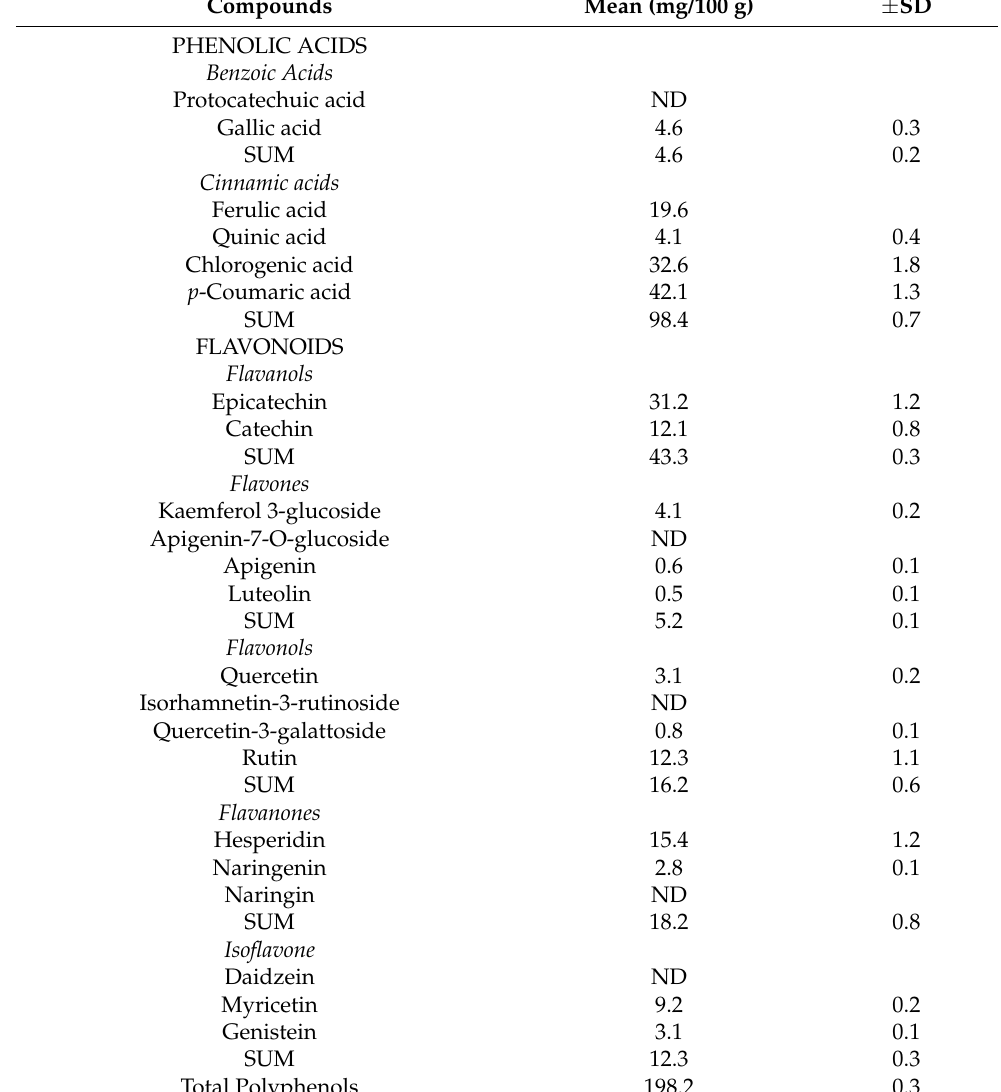
Table 2. Flavonoids and phenolic acids content in broad bean hull